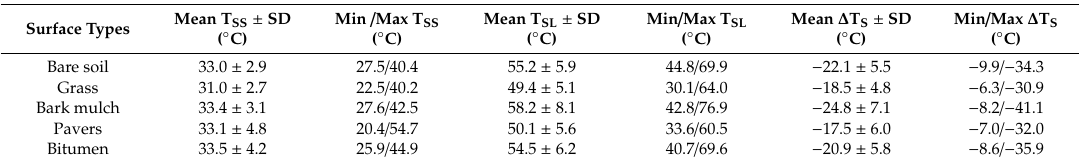
Table 2. Mean, minimum and maximum shaded surface temperature (T SS ), sunlit surface temperature (T SL ) and surface temperature differential ( Δ T S ) recorded on bare soil, grass, bark mulch, concrete pavers and bitumen.